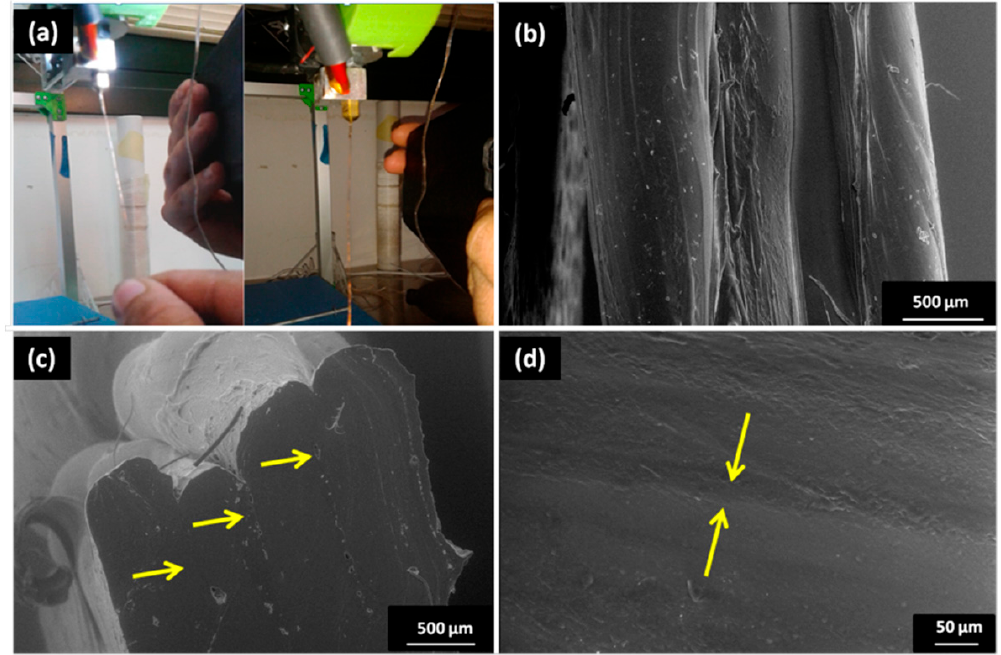
Figure 6. Photos of ( a ) the neat PDMS and composite Na–CMC/PDMS filaments used in FDM; SEM images, at different magnification, of ( b – d ) the composite filament printed in layers. Arrows indicate the interface between different layers.